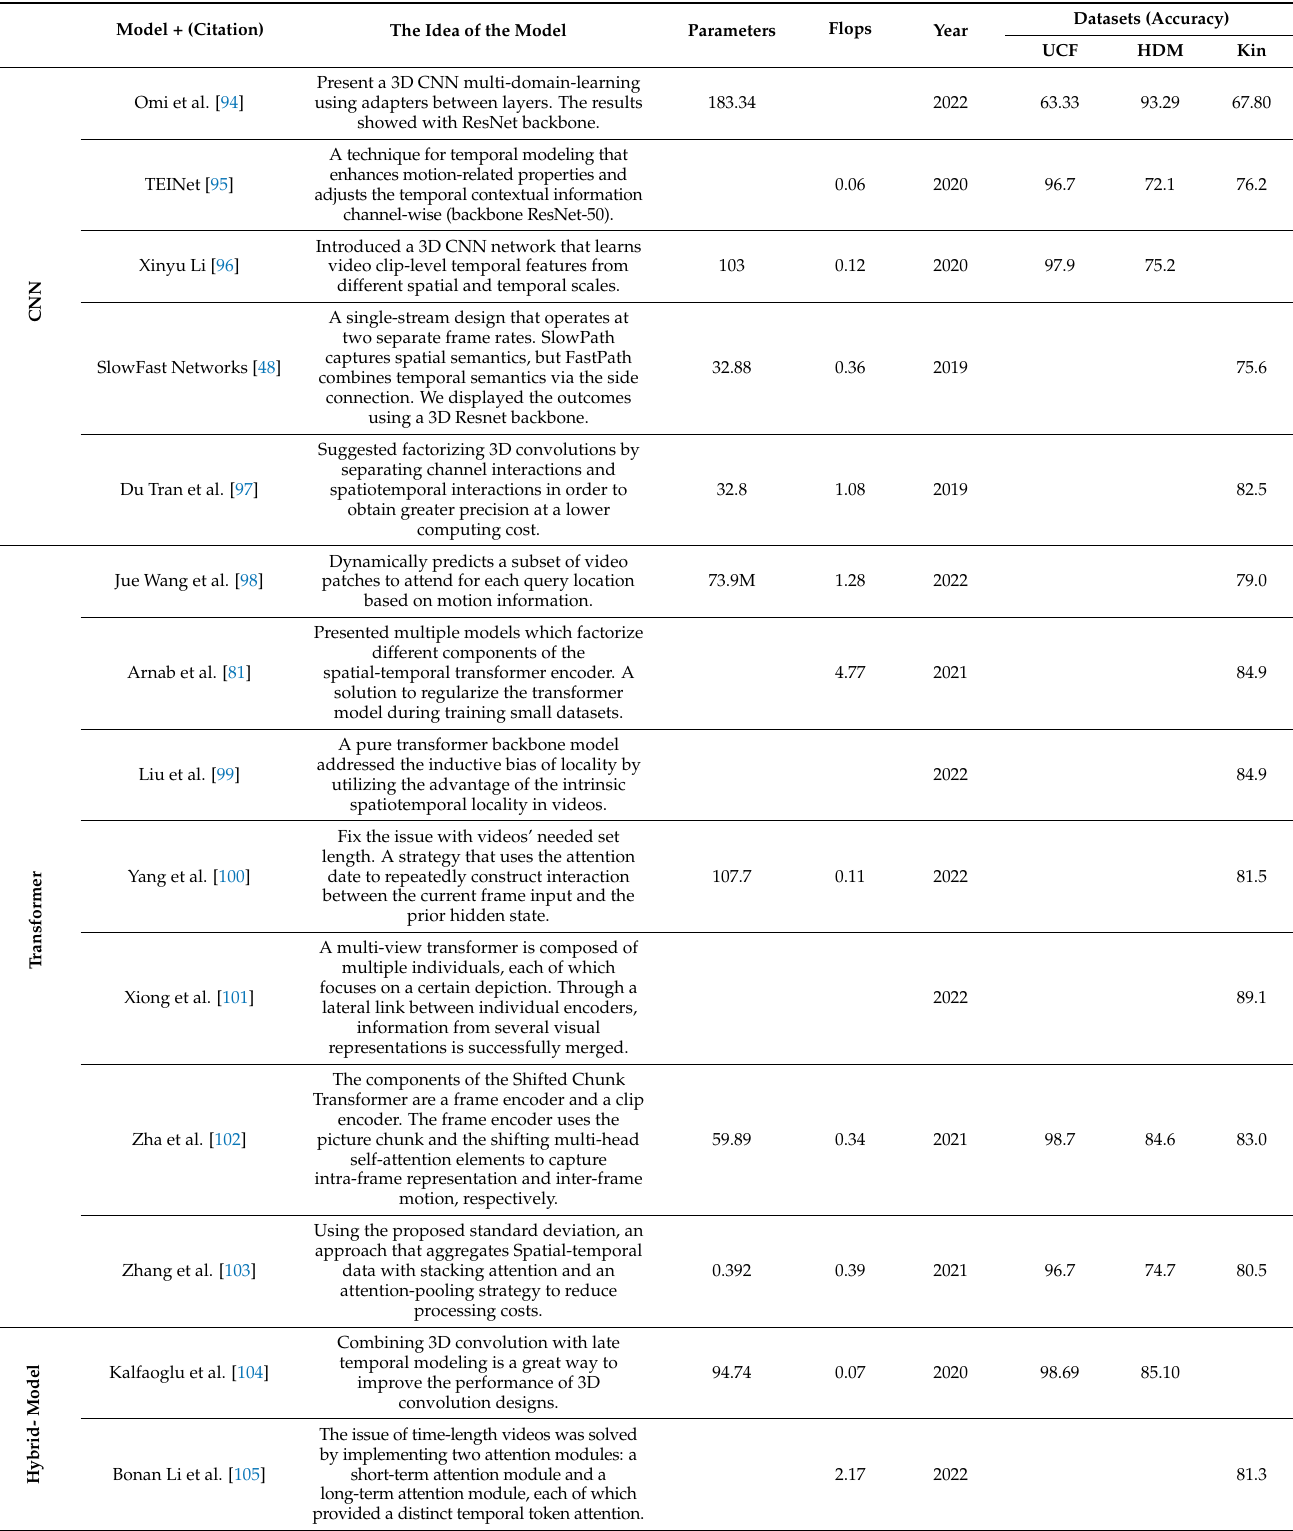
Table 2 presents a comparison of the accuracy and complexity of the CNN, Transformer, and Hybrid model techniques for the recognition of actions. Table 2. RGB comparison of CNN, Transformer, and Hybrid model approaches for Action